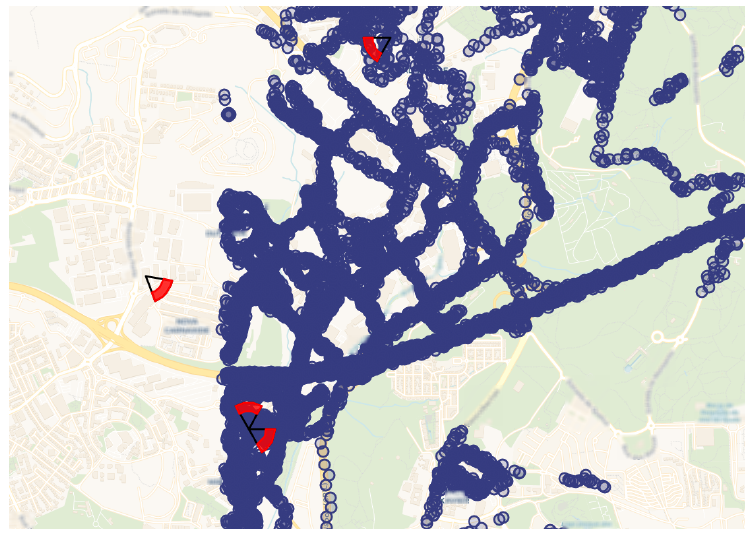
Figure 19. The joint service area of the cells for